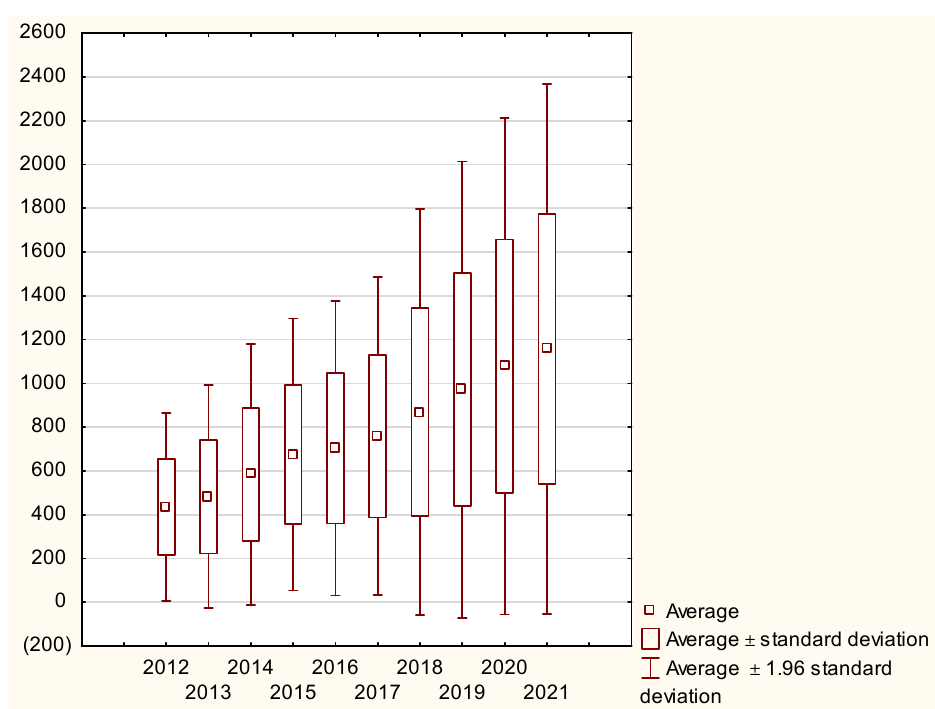
Figure 1. Box-plot for variability of bike road lengths in following years. Source: Author own anal- ysis.